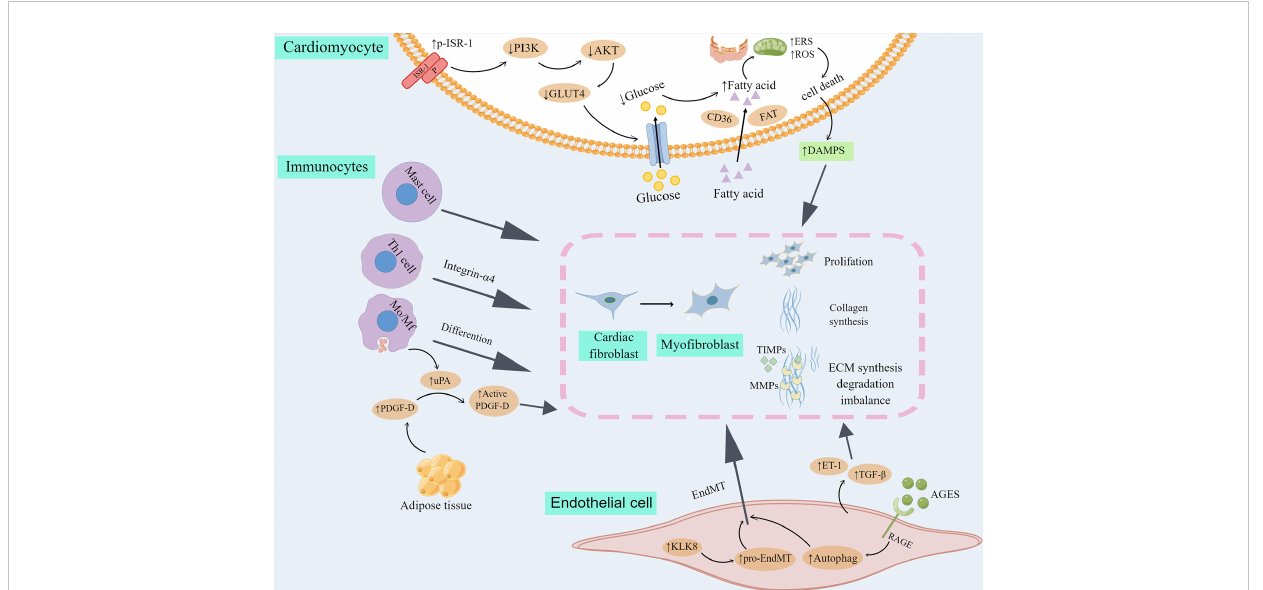
FIGURE 1 Cell types involved in myocardial fi brosis and remodeling in DCM. Transdifferentiation from cardiac fi broblast to myo fi broblast is the core cellular event in cardiac fi brosis in DCM. 1) Myo fi broblasts produce high level of collagen and other extracellular matrix proteins (ECM), and secrete matrix metalloproteinases (MMPs) as well as their inhibitors, tissue inhibitors of metalloproteinases (TIMPs), taking part in the progression to fi brotic remodeling. 2) Insulin resistance leads to the metabolic transformation of cardiomyocytes from glucose metabolism to fatty acid b oxidation, increased cell metabolic pressure, reactive oxygen species (ROS) and endoplasmic reticulum stress (ERS) and fi nally led to the death of cardiomyocytes. DAMPs released in in fl ammatory reaction by dead myocardial cells activate cardiac fi broblasts. 3) Immunocytes, including mast cell, Th1 cell and Mo/Mf could directly differentiate into myo fi broblasts or indirectly promote cardiac fi broblast transdifferentiate into myo fi broblast. 4) Endothelial cells were transformed into mesenchymal cells (EndMT), and further into myo fi broblasts. In addition, fi brogenic mediators produced by endothelial cells participate in the proliferation and differentiation of myocardial fi broblasts. By Figdraw. ISR-1, insulin receptor substrate 1; P, phosphorylation; PI3K, phosphatidylinositol 3-kinase; GLUT4, glucose transporter 4; CD36, cluster of differentiation 36; FAT, fatty acid translocatase; DAMPS, danger-associated molecular patterns; Mo/Mf, monocytes/macrophages; PDGF-D, platelet-derived growth factor-D; uPA, urokinase plasminogen activator; KLK8, kallikrein-related peptidase 8; ET-1, endothelin 1; AGES, advanced glycation end products; RAGE, AGES receptor; TGF- b , transforming growth